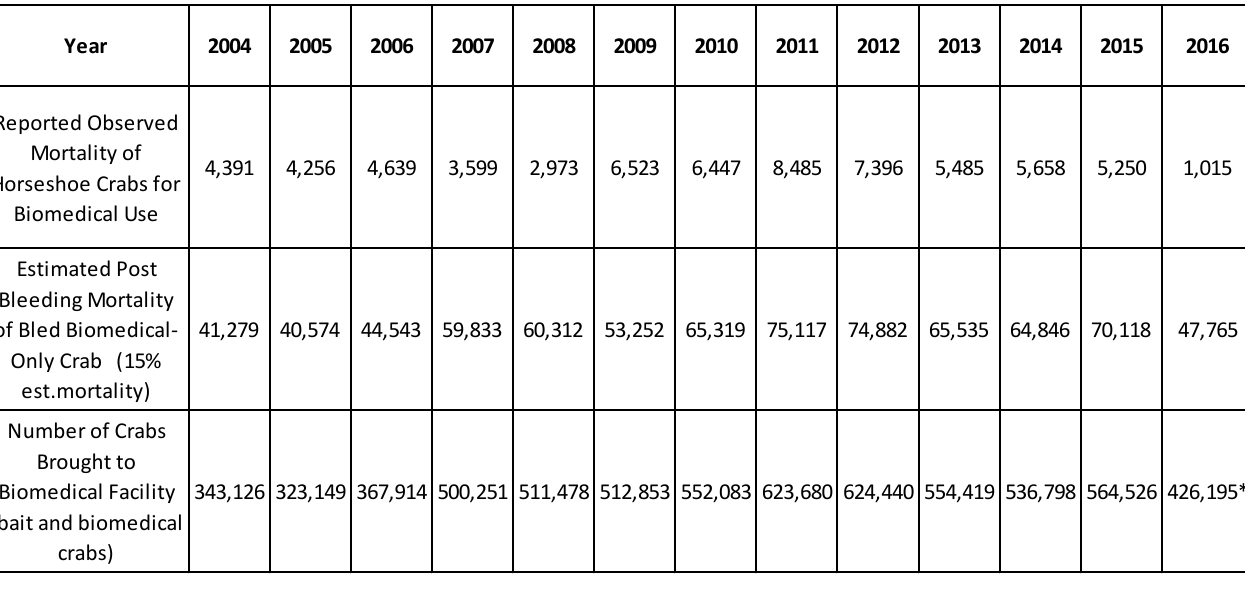
Table 1. Biomedical horseshoe crab mortality